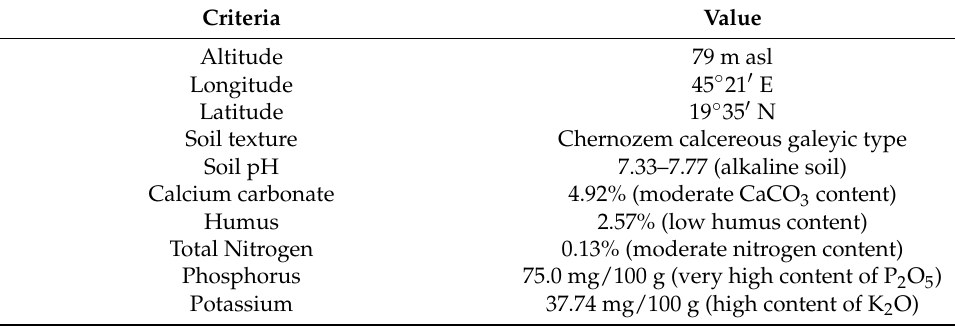
Table 1. Characteristics of the experimental site conditions.